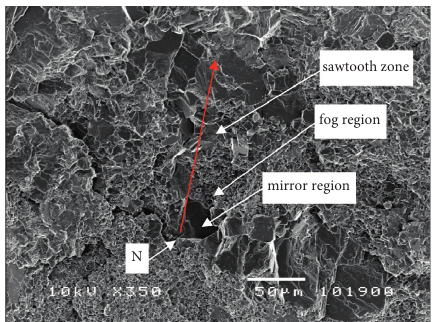
Figure 21: Mirror area, fog area, toothed belt on the marble fracture surface.